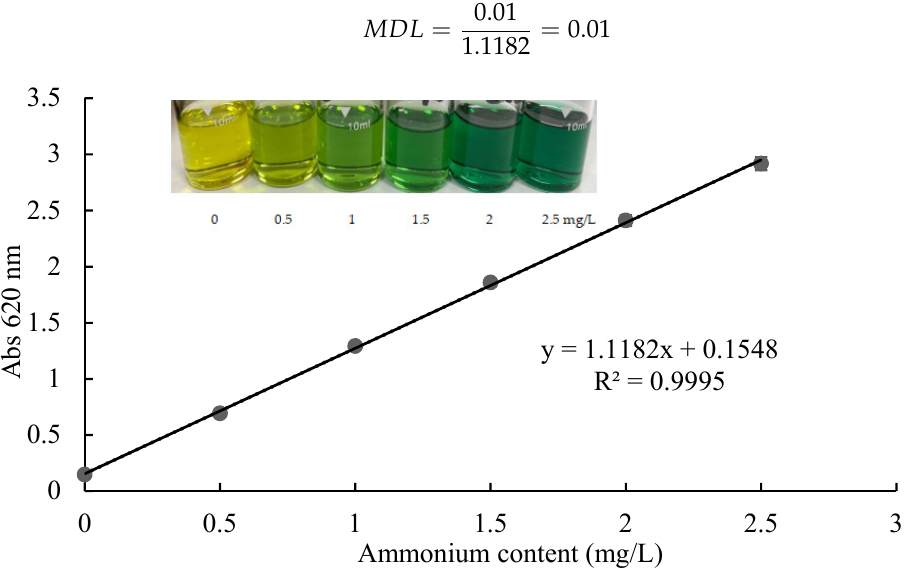
Figure 2. The ammonium standard curve and color change of the reaction for the test kit .